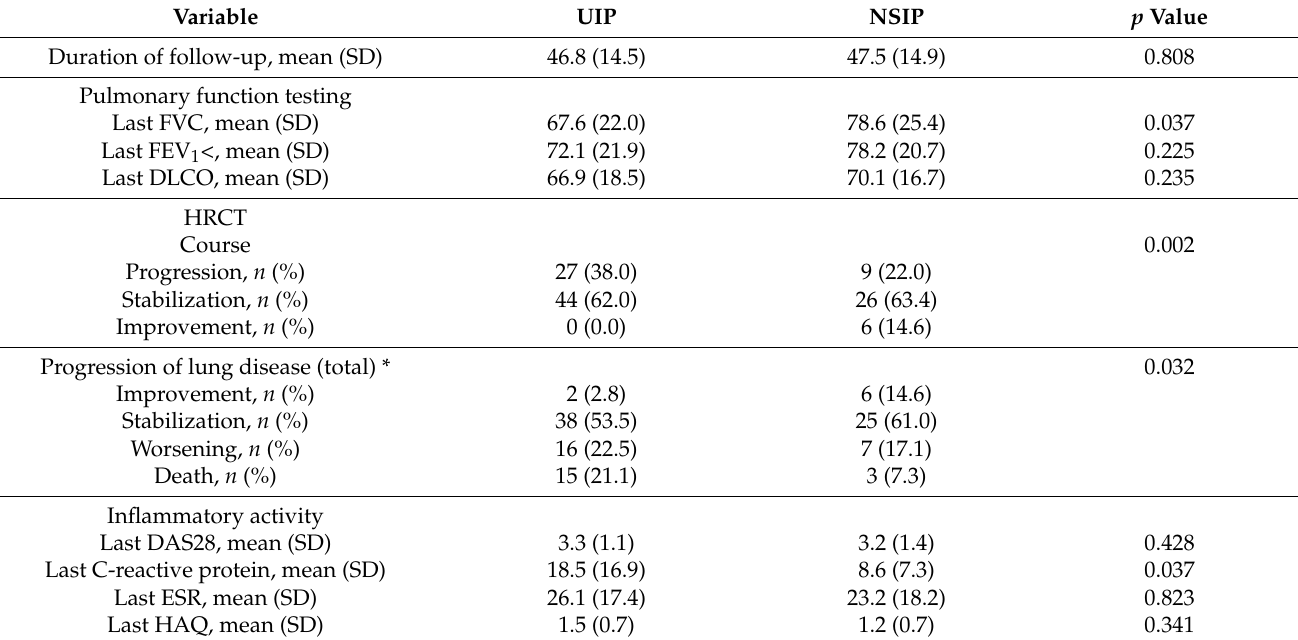
Table 4. Comparison of progression of symptoms and lung disease in patients with RA-ILD according to radiological pattern (UIP or